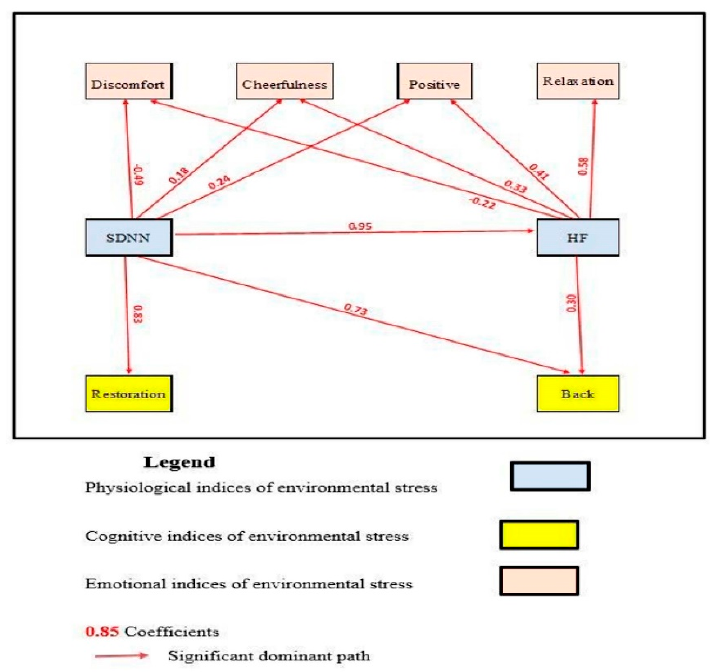
Figure 2. An AMOS SPSS path model of indices of coping with environments.